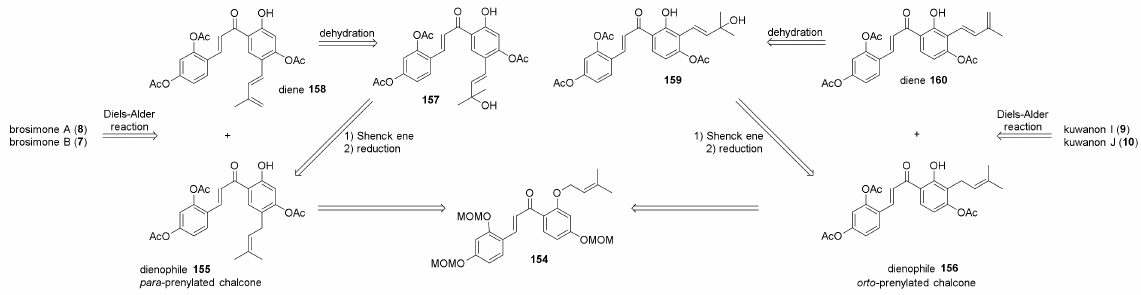
Figure 52. Retrosynthesis of brosimones A and B ( 8 and 7 ) and kuwanons I and J ( 9 and 10